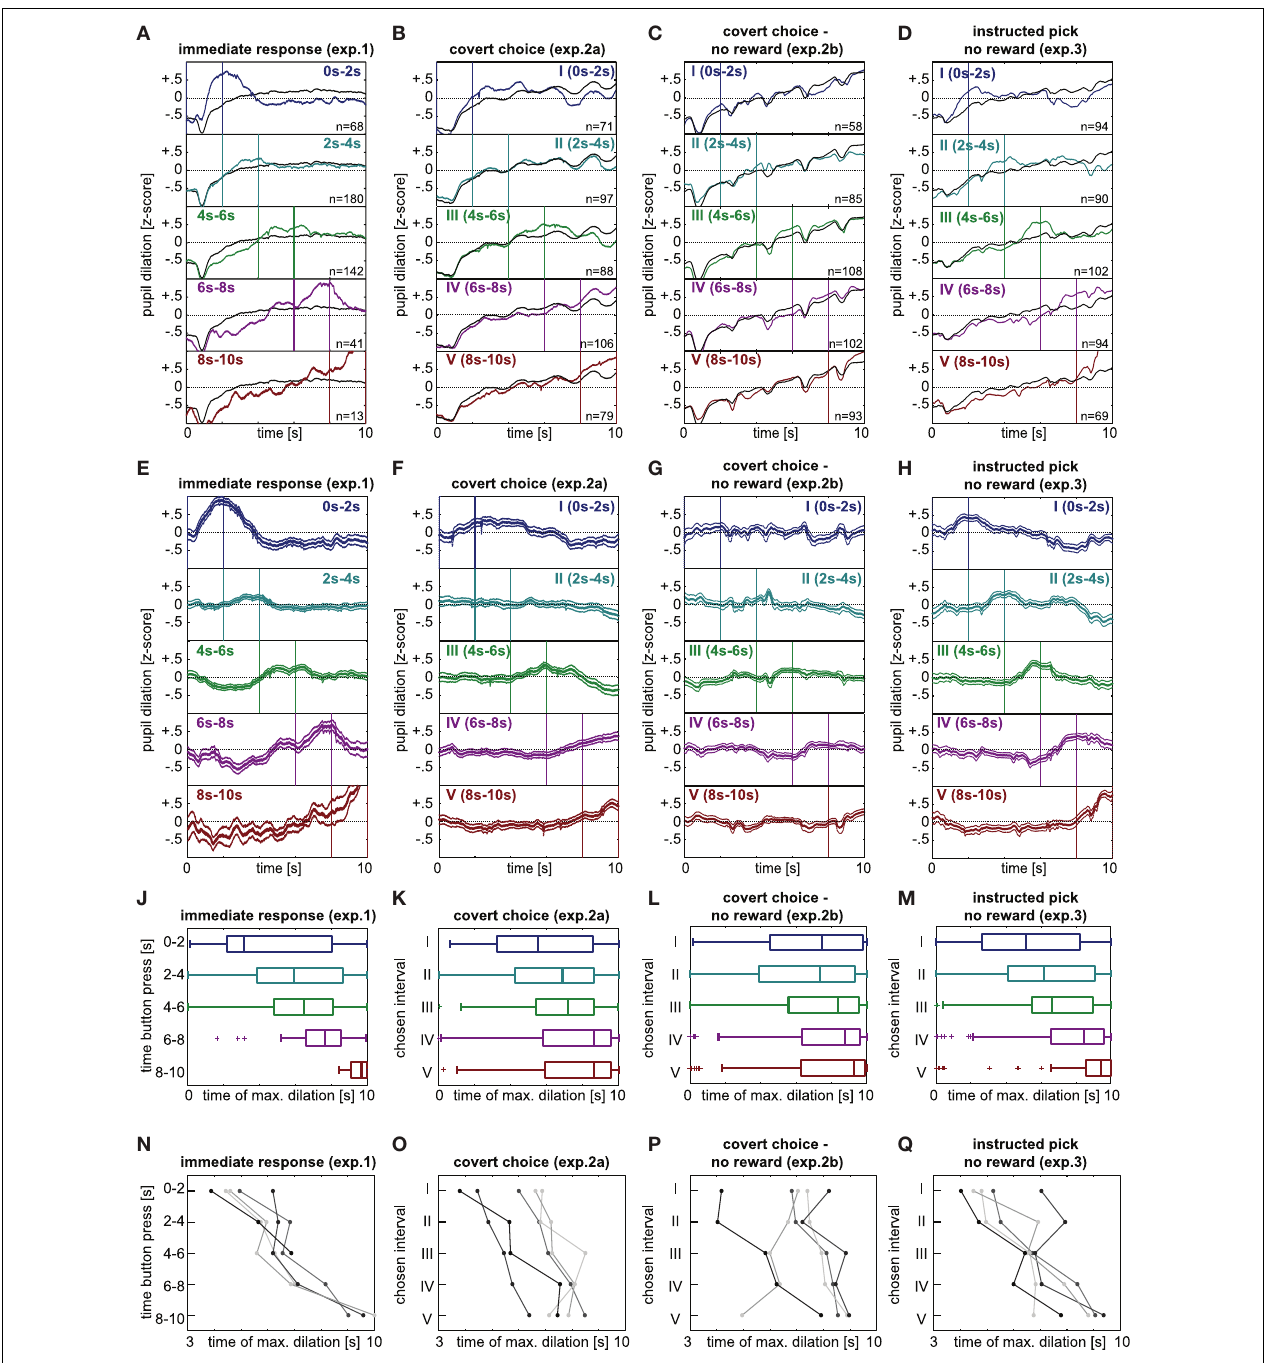
experiment 2b is mainly a consequence of one observer with opposing trend (see P and text). (J–M) Time of maximum (non-normalized) pupil dilation grouped by chosen interval. Boxes denote quartiles, lines medians, whiskers the whole data range, except outliers beyond 1.5 times the interquartile range (crosses). (J) Experiment 1 (K) Experiment 2a (L) Experiment 2b (M) Experiment 3. (N–Q) Mean time of maximum (non-normalized) pupil dilation grouped by chosen interval, separated by individuals. Each individual encoded by distinct shade of gray. Note that the individuals do not overlap across experiments. (N) Experiment 1 (O) Experiment 2a (P) Experiment 2b (Q) Experiment